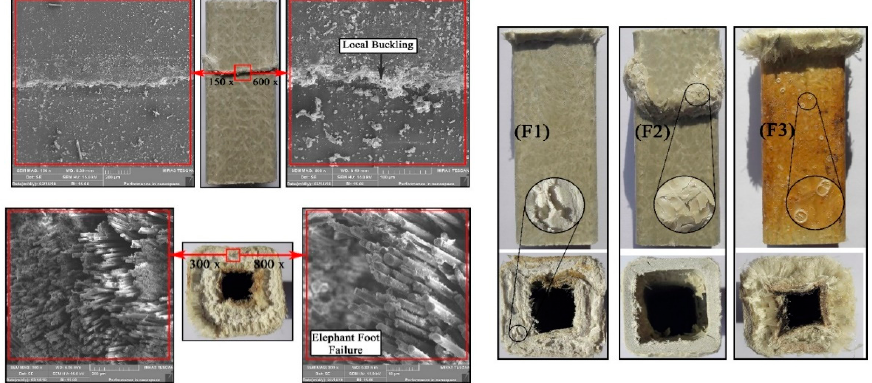
Figure 9. Typical failure modes of compressive pultruded GFRP profiles [137]. Wang and Wong [138] tested pultruded GFRP channel columns in compression at temperatures ranging from 20 to 120 °C. The effect of column height (ranging from 0.5 to 1.5 m) and the rotational restraints about major and minor axes were investigated. It was shown that the columns tested about the minor axis failed due to the global buckling towards the web and lost up to 66% of their compressive strength at 120 °C. Regarding the columns tested about the major axis, short columns failed due to the combination of material crushing and buckling, while the longer columns failed in either local or global buckling. This type of columns showed up to 38% compressive strength reduction at 120 °C. Short channel columns (100 × 30 × 4 mm and 30 mm long) were also tested at a wider range of temperatures (i.e., 20–250 °C) by Wang et al. [131,138] and up to 92% compressive strength reduction was reported at 250 °C.